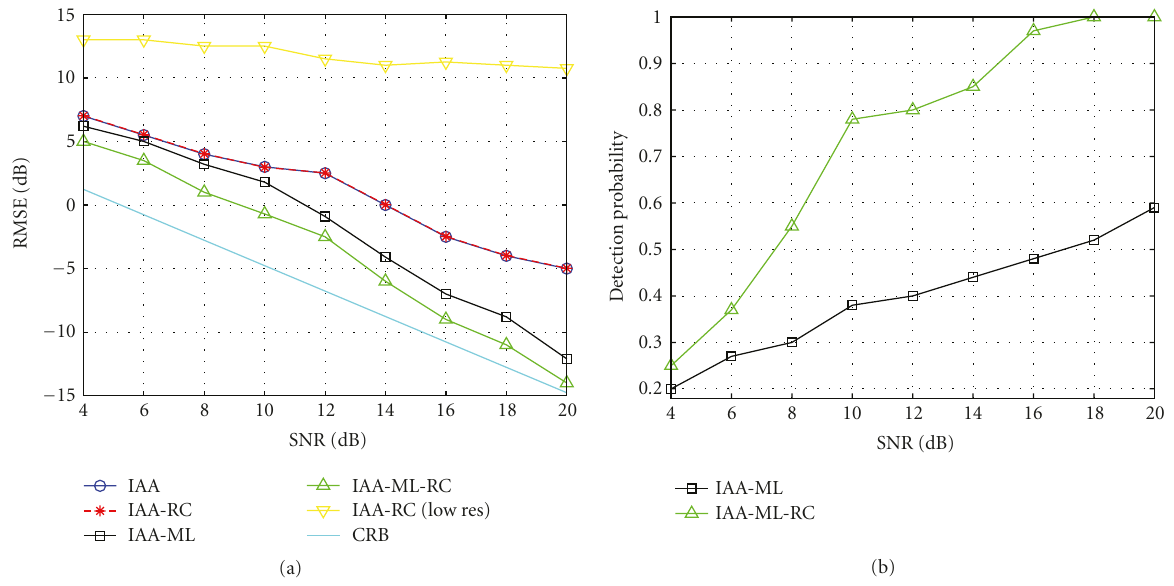
Figure 12: (a) RMSE of the di ff erent beamforming solutions. (b) IAA-ML versus IAA-ML-RC detection probability (rectangular array, θ 1 = 10 ◦ , φ 1 = 150 ◦ , θ 2 = 40 ◦ , φ 2 = 188 ◦ , θ 3 = 20 ◦ , φ 3 = 250 ◦ , N = 3 snapshots, noise power equal to 0dB, and f c =